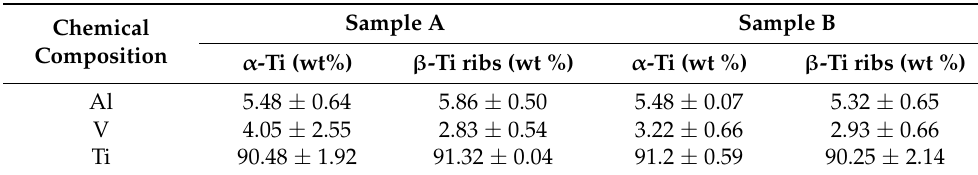
Table 1. Chemical composition of α -Ti phase and β -Ti ribs in PBF-EB AM Ti6Al4V with different scanning strategies.